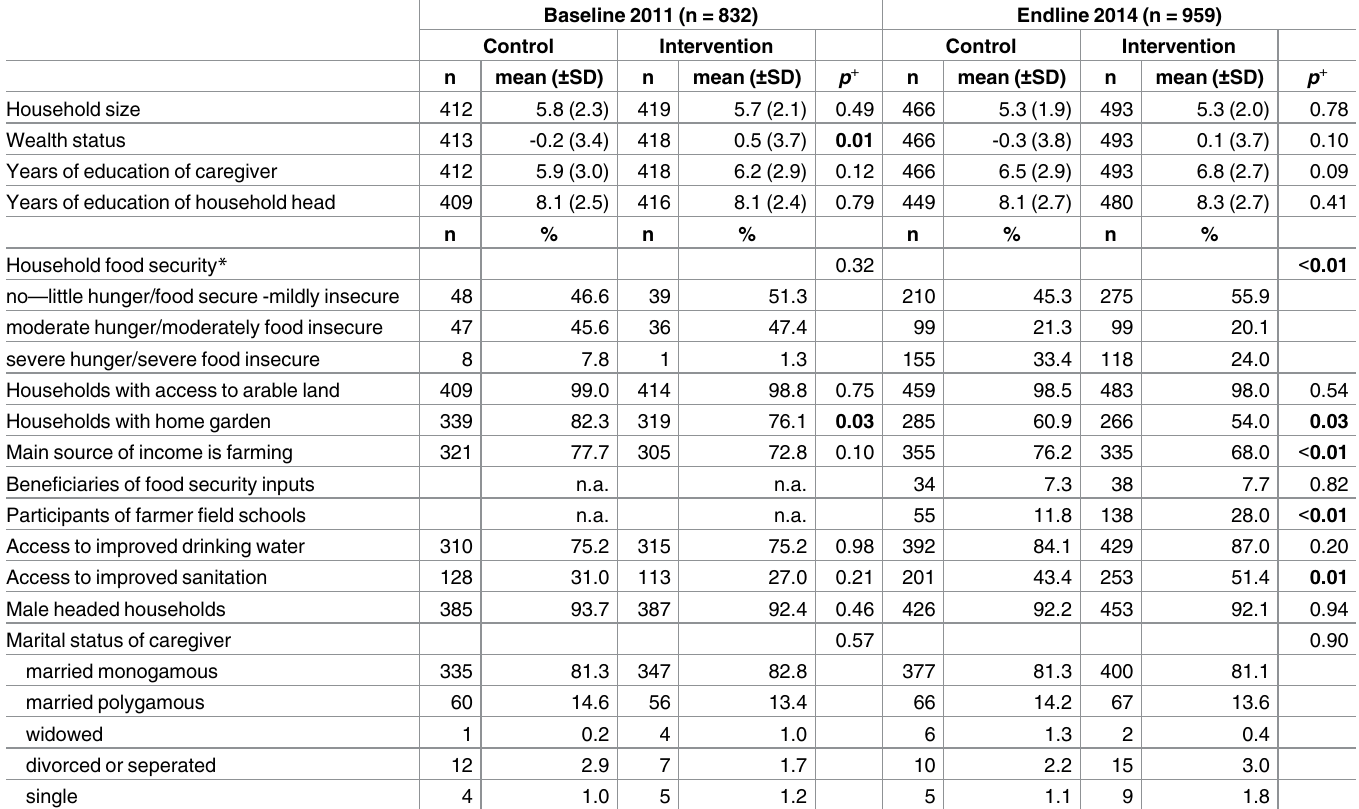
Table 2. Household characteristics at baseline and